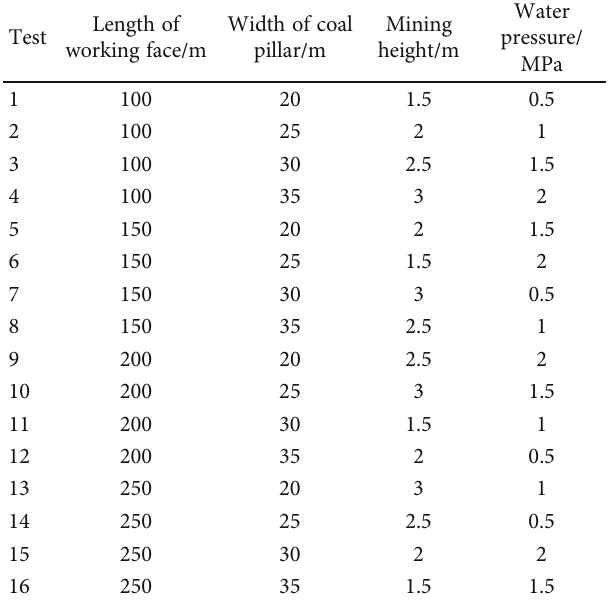
Table 1: Simulation scheme of orthogonal